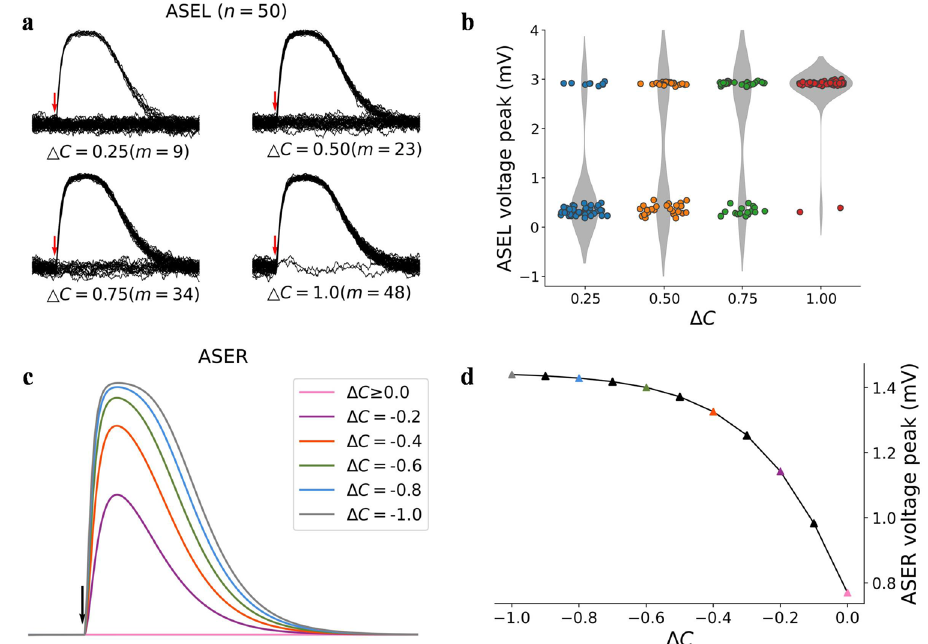
Figure 1. Voltage responses of ASE model evoked by up-/down-steps. ( a ) Voltage traces of ASEL neuron. m is the number of depolarizations evoked. ( b ) Voltage peaks of traces in ( a ), shown by colored dots. The gray areas are the violin plots, representing the kernel density estimations. ( c ) Voltage traces of ASER neuron. ( d ) The ASER voltage peak vs. down-step. The vertical arrows in ( a ), ( c ) indicate the onset times of stimuli.